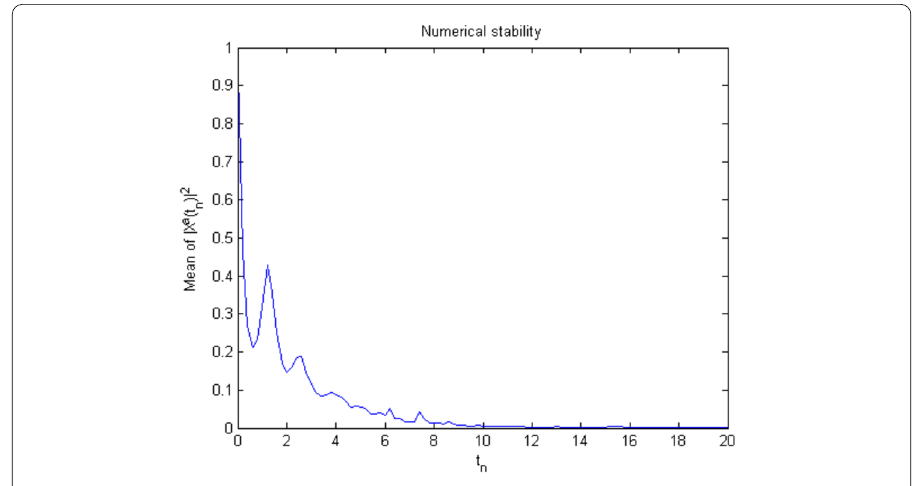
Figure 5 The average of numerical solution over 10,000 discretized Brownian paths with h = 0.2 and T = 20 for Example 5.1